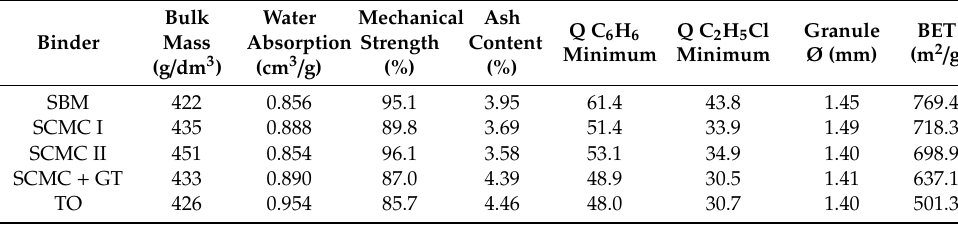
Table 9. Average properties of final GAC granules with di ff erent